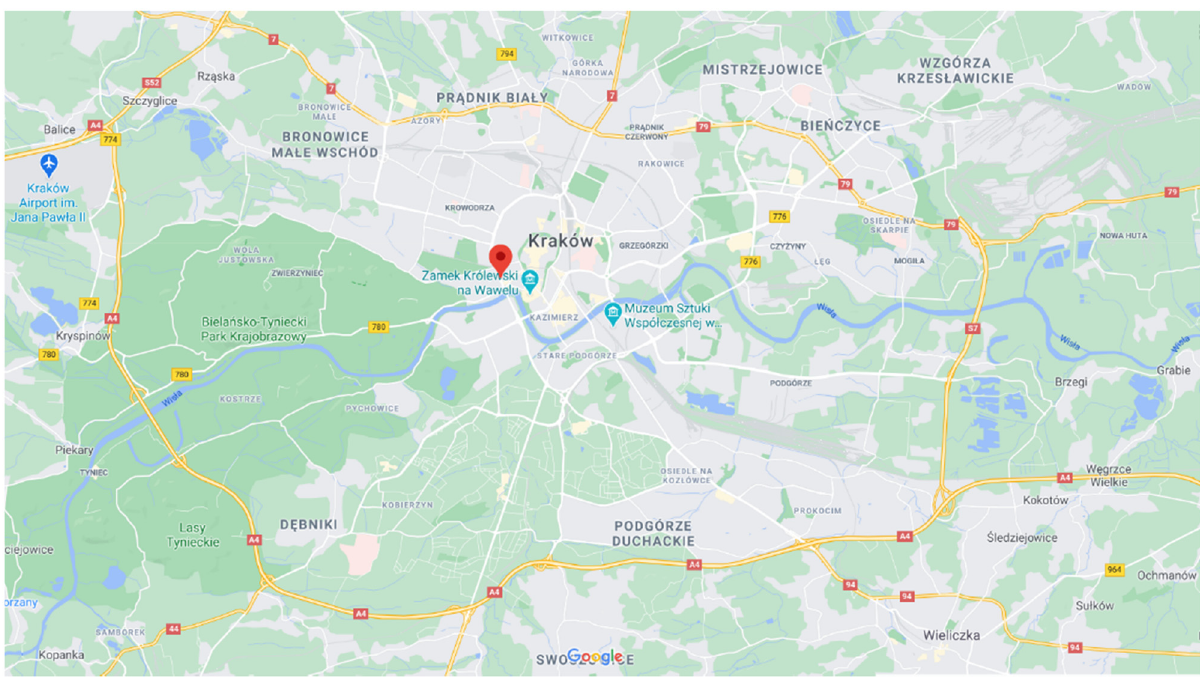
Figure 2: Location of Krasinskiego Avenue within the city of Krakow [ 26 ] .